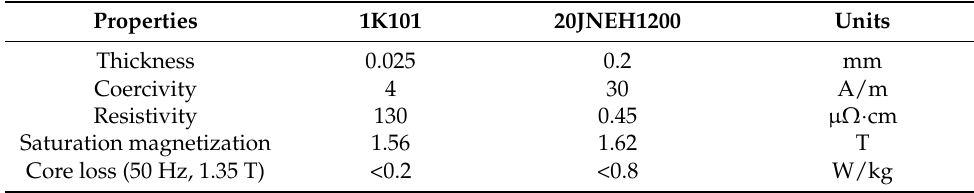
Table 1. Material Properties